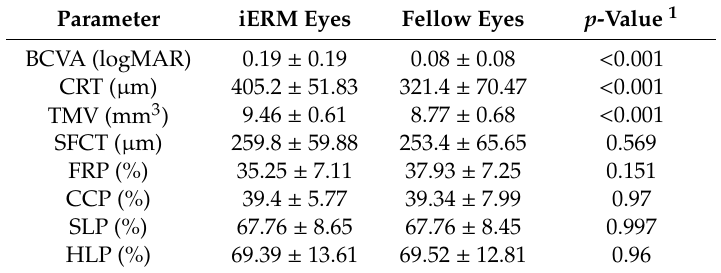
Table 5. Anatomical and functional parameters of iERM and fellow eyes at 3 months follow up examination.